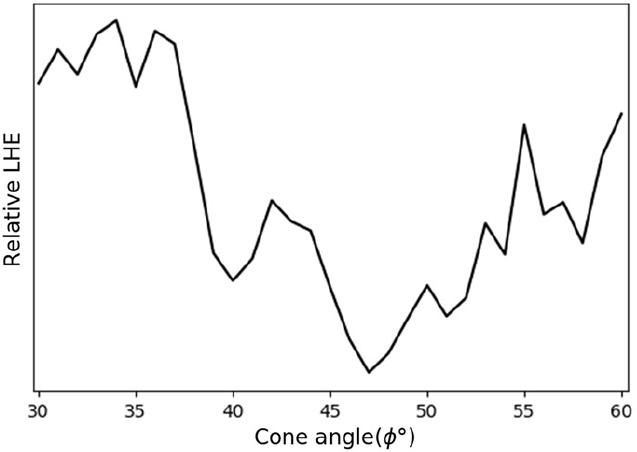
Figure 2. The relative LHE as a function of the cone-shaped Ag back-reflector’s sidewall angle φ calculated using 2D FDTD simulations. The nanopillar diameter is 50 nm. The edge-to-edge spacing between two adjacent pillars is 50 nm. The TiO 2 grating is not